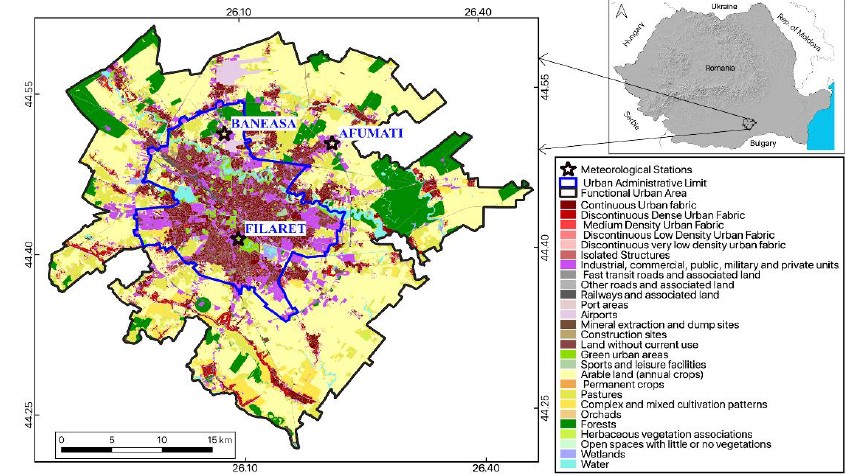
Figure 1. Urban administrative limit and functional urban areas (FAU) of Bucharest. (Source: Urban Atlas LCLU 2012, available online at <https://land.copernicus.eu/local/urban-atlas/urban-atlas-2012>).